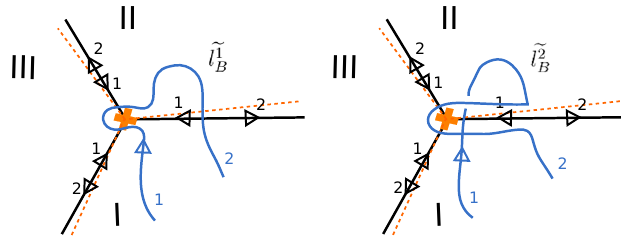
Figure 60 . Moving a strand across a critical leaf.